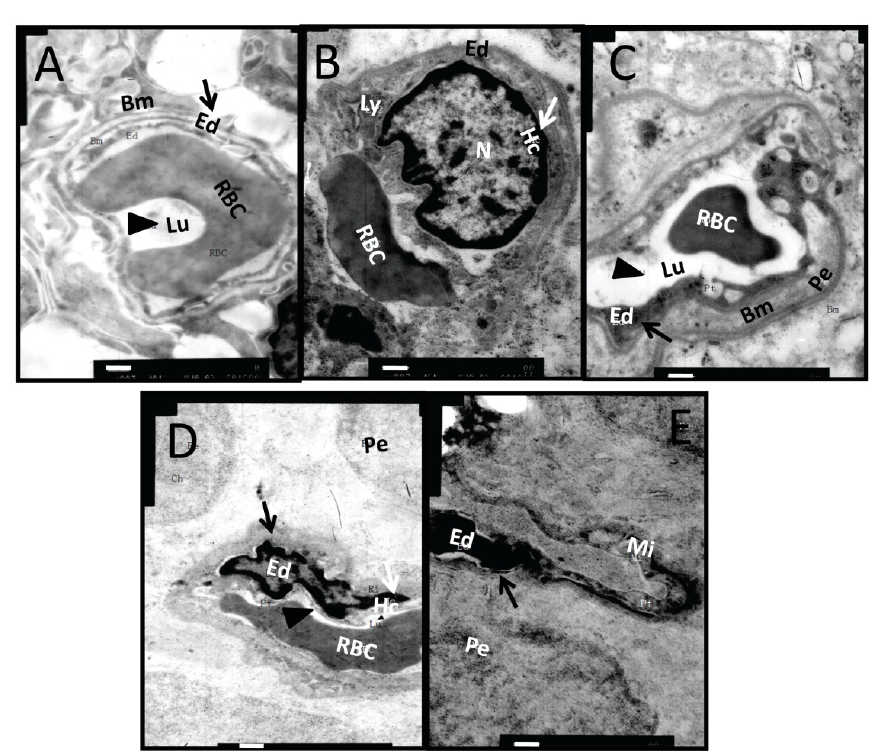
Figure 7. The ultrastructural changes in retinal microvessels of diabetic rats after dual-target intervention. One week after intervention, the ultrastructure changes of retinal microvessels were examined by TEM in normal controls ( A ); diabetic rats without intervention ( B ); diabetic rats subjected to ranibizumab and CTGF shRNA dual-target intervention ( C ); and diabetic animals subjected to ranibizumab ( D ) or CTGF shRNA ( E ) single-target intervention. Representative pictures are shown ( n = 5). Black triangles indicate capillary lumen, black arrows indicate endothelial cells, and white arrows indicate heterochromatin. Bm: Basement membrane, Lu: capillary lumen, Ed: endothelial cell; Ly: lysosomes; Pe: pericyte; Mi: mitochondria, N: nucleus, Hc: heterochromatin, RBC: red blood cell. Scale bar = 500